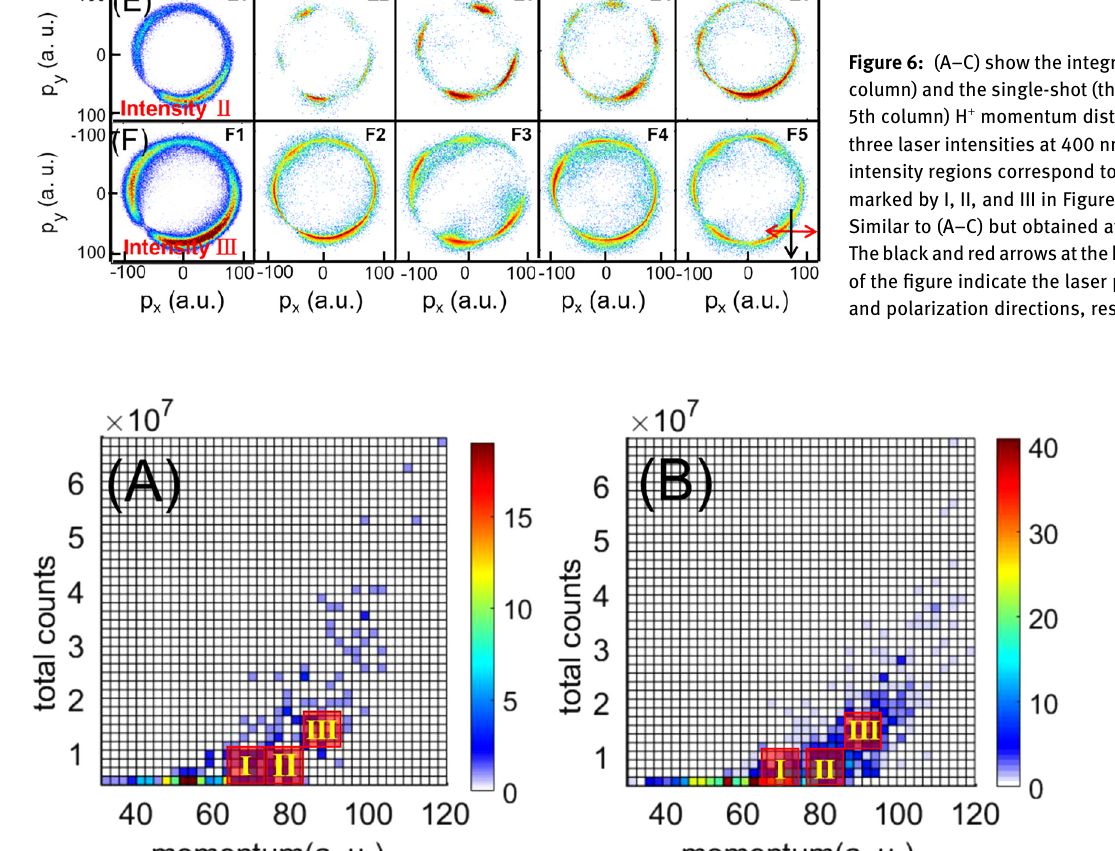
Figure 7: (A) and (B) are statistics of thousands of single-shot measurements sorted by the momentum of the maximum counts and the correspondingtotalcountsoftheimage,at400and800nm,respectively.Thecolorbarrepresentsthenumberofimagessatisfyingtherelated parameters. Three regions marked I, II, and III are selected corresponding to three distinct intensity